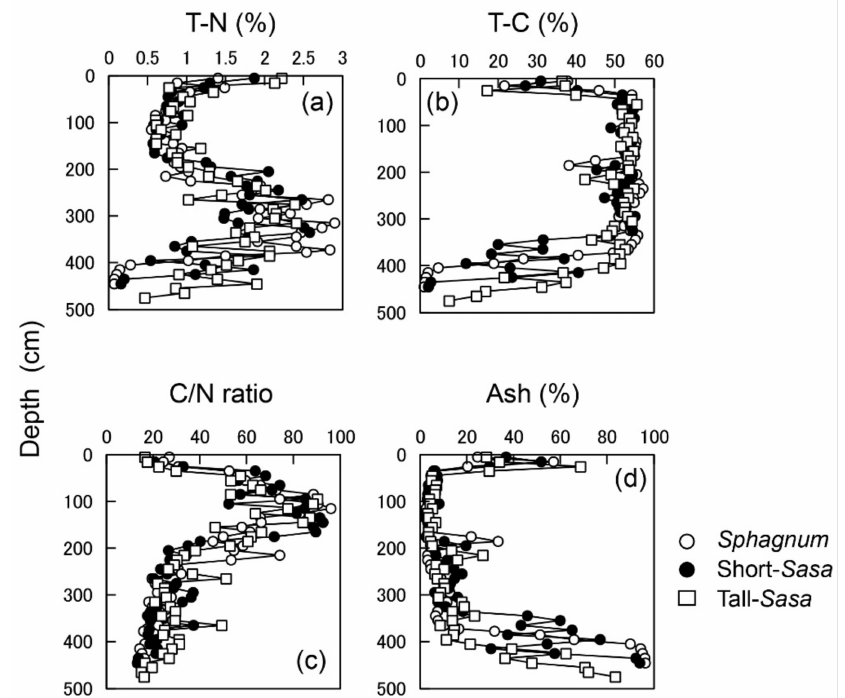
Figure 2. Peat C and N content ( a , b ), C/N ratio ( c ), and ash content ( d ) by depth in the Bibai wetland. The high ash content and low T-C content of the peat at a depth of 10–30 cm is due to the contamination of volcanic